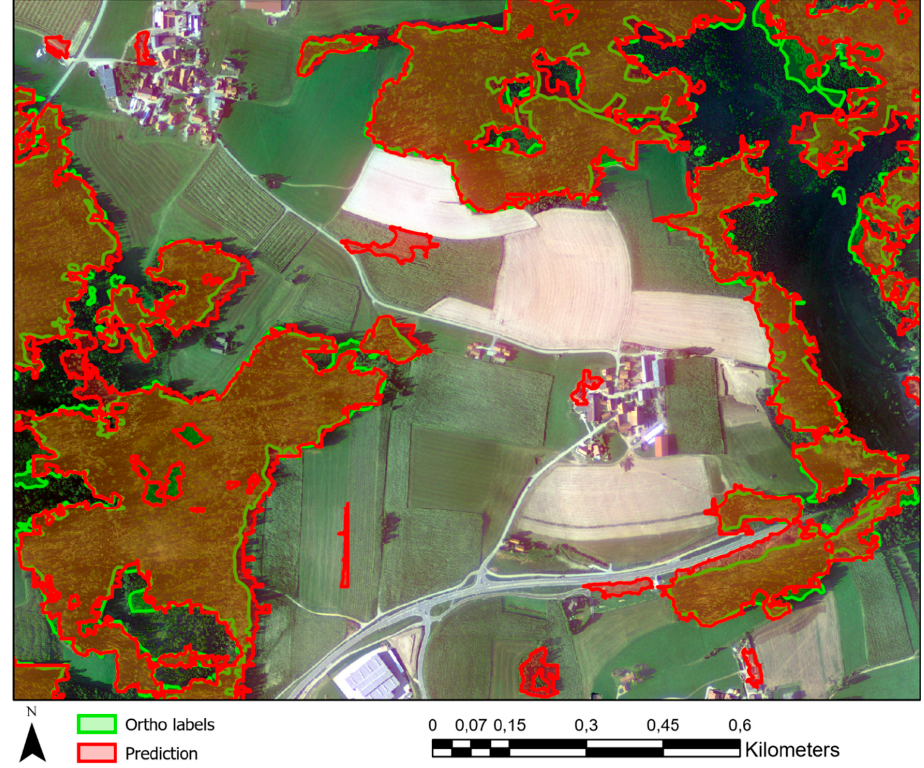
Figure 9. Prediction on orthophoto from an aerial flight campaign (red) compared to the labels (green).